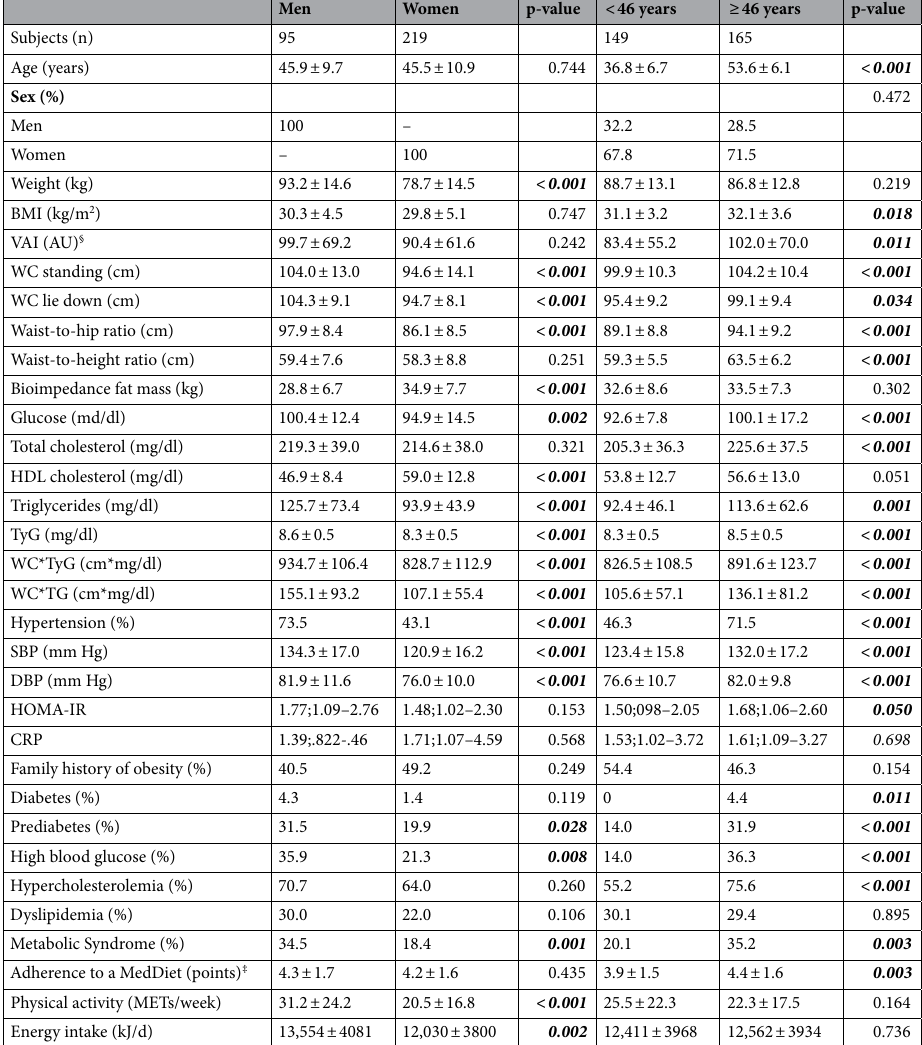
Table 1. Baseline characteristics of the study sample. Variables are shown as mean ± SD, as percentage or as median and interquartile range according to their distribution. § AU: Arbitrary Units. BMI: body mass index; VAI: Visceral Adiposity Index; WC: waist circumference; TG: triglycerides; SBP: Systolic Blood Pressure; DBP: Diastolic Blood Pressure; CRP: C-reactive protein; MedDiet: Mediterranean diet. ‡ Adherence to the Mediterranean diet measured with the Mediterranean Diet Score